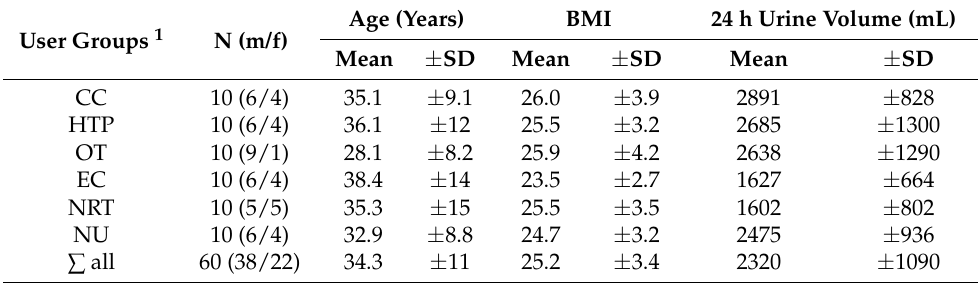
Table 2. Main characteristics of the study population.